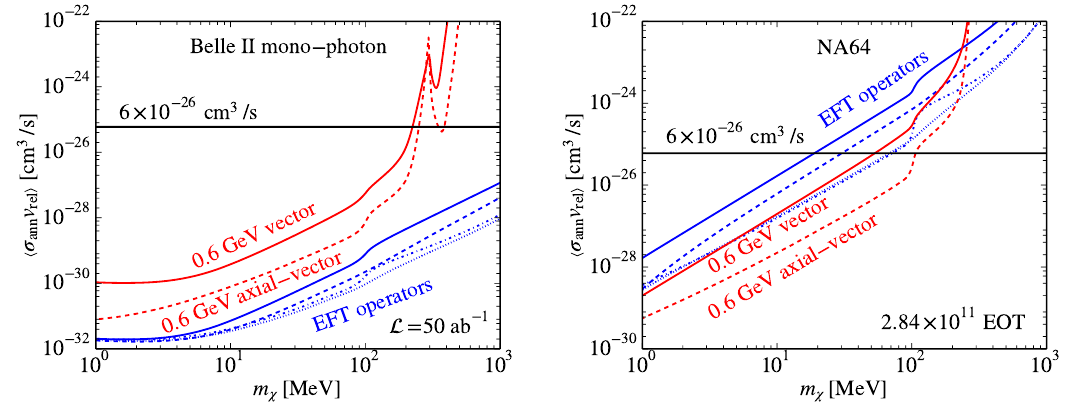
Figure 12 . Left panel: Belle II 90% C.L. upper bound from the mono-photon channel with 50 ab − 1 data on the thermally averaged DM annihilation cross section h σ evaluated at the freeze-out ann v rel i temperature. The blue lines correspond to the limits in figure 1 on EFT operators: O (dot-dashed), A O V (solid), O s (dotted), and O t (dashed). The red solid and dashed lines correspond to the m Z 0 = 0 . 6 GeV models in figure 2 and 3 respectively. Right panel: NA64 90% C.L. upper bound with 2 . 84 × 10 11 EOT data on the thermally averaged DM annihilation cross section evaluated at the freeze-out temperature. The blue lines correspond to the limits in figure 10 on EFT operators. The red solid (dashed) lines correspond to the m = 0 . 6 GeV vector-only (axial-vector-only) model in figure 11. Z 0 The black solid line indicates the thermal cross section for the Dirac DM, 6 × 10 − 26 cm 3 / s [93].